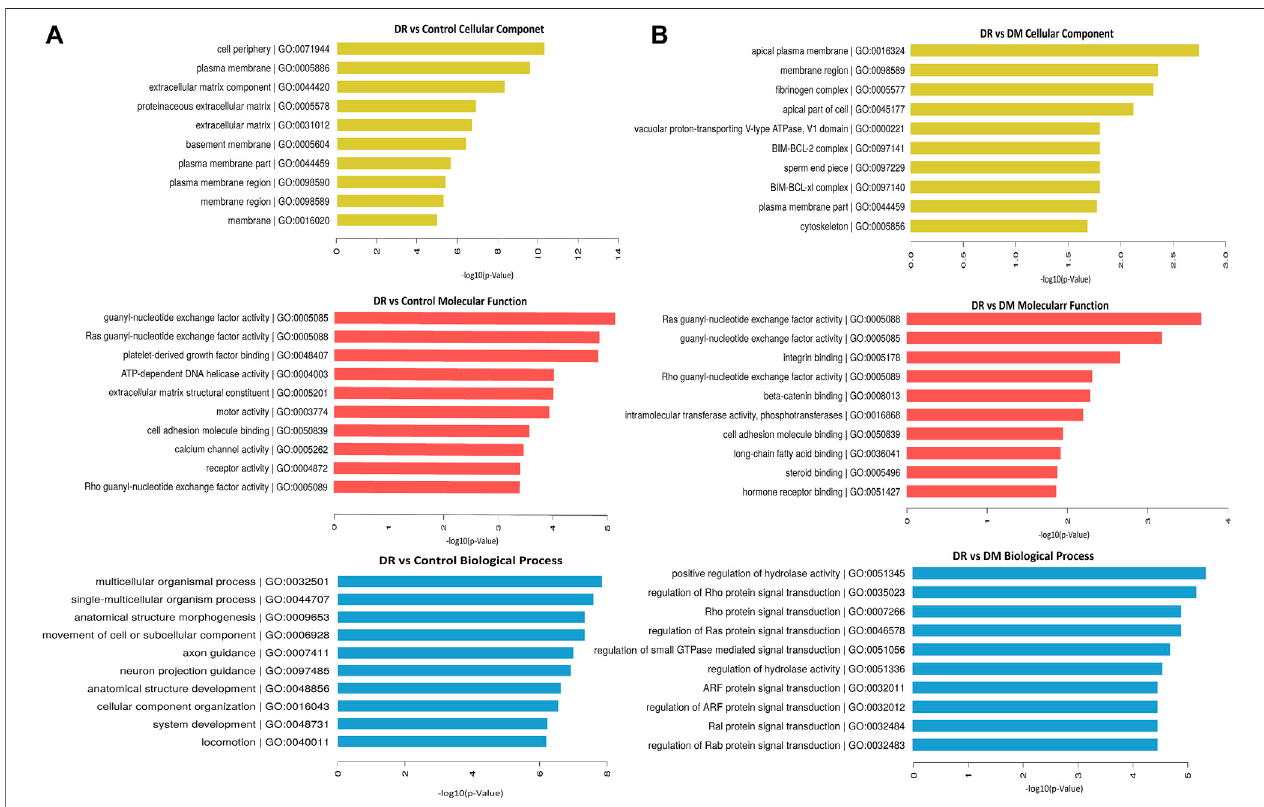
FIGURE 2 | Differentially expressed circRNAs in DR samples by GO analysis. (A) DR vs control group, (B) DR vs DM group.